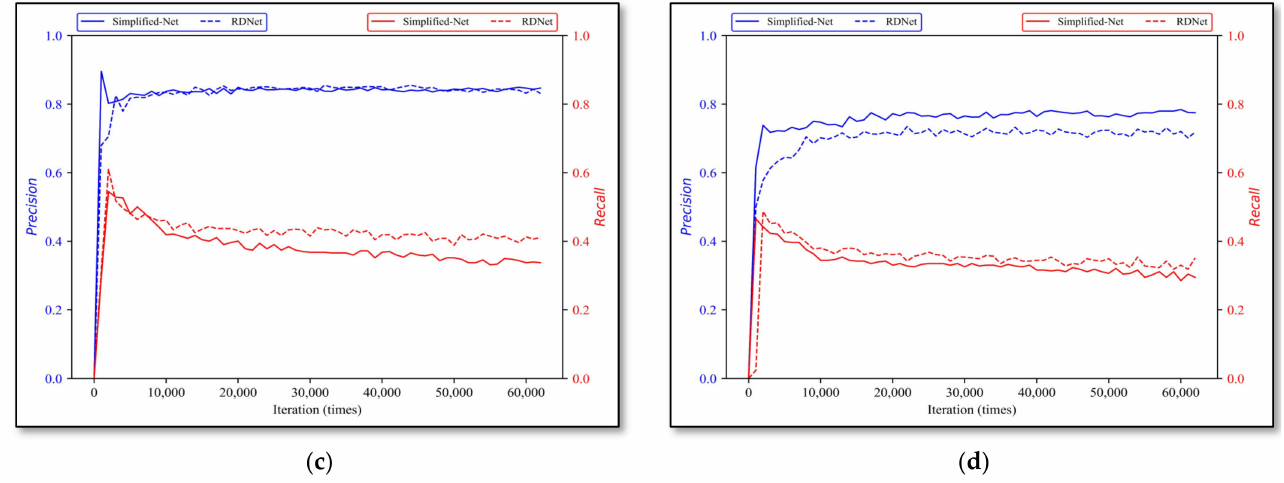
Figure 12. Simplified-Net and RDNet evaluation results. ( a ) monzogranite, ( b ) sandstone, ( c ) shale, and ( d ) tuff.